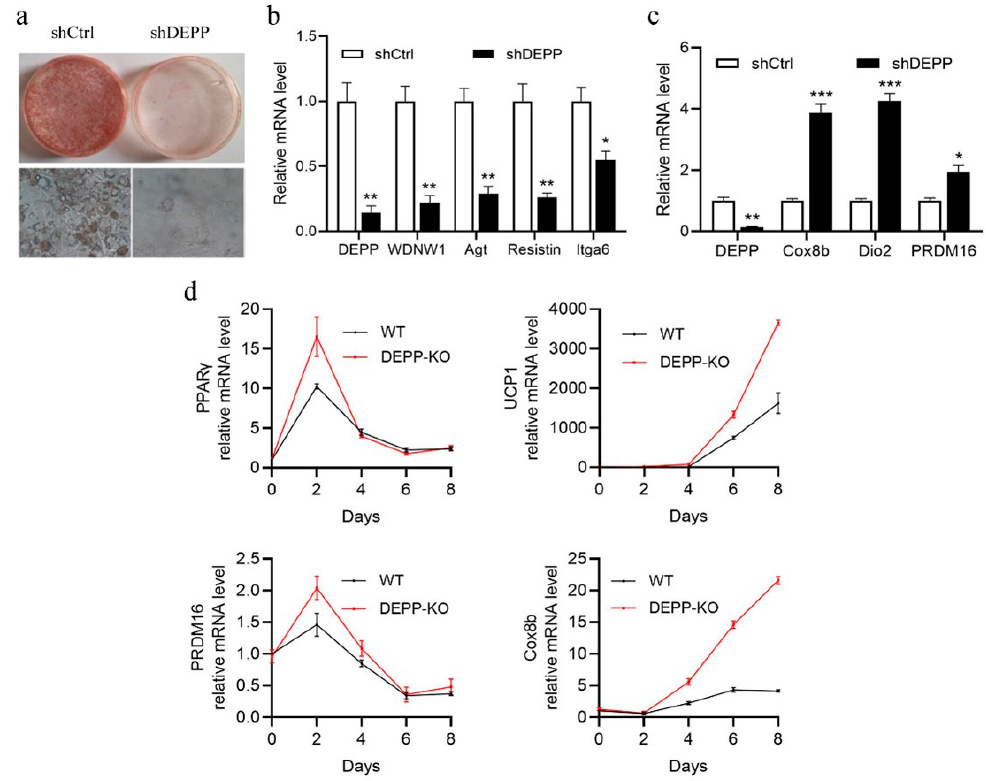
Figure 1. DEPP deficiency reduced lipid storage in white adipocytes and induced browning of adipocytes. ( a , b ) 3T3-L1 cells with Depp knockdown by shRNA (shDepp) and their control cells with schrambled shRNA (shCtrl) were induced differentiation with the hormone cocktail dexamethasone– methylisobutylxanthine–insulin (DMI). ( a ) Oil Red O staining images and their magnified images are shown. ( b ) Relative mRNA levels of white adipocyte marker genes. ( c ) Primary brown adipocytes were isolated from the brown adipose tissue in the scapular region of newborn mice. DEPP was silenced by Depp shRNA. Relative mRNA levels of brown adipocyte marker genes were determined after cell differentiation. ( d ) MEFs isolated from DEPP knockout (KO) mice and wild-type (WT) littermates were induced for differentiation. The dynamic mRNA level of brown adipocyte marker genes was measured at 0, 2, 4, 6 and 8 days of differentiation. The data of b, c and d were obtained from triplicate biological samples. The results are presented as the means ± SD, two-tailed Student’s t -test: * p < 0.05, ** p < 0.01, *** p <